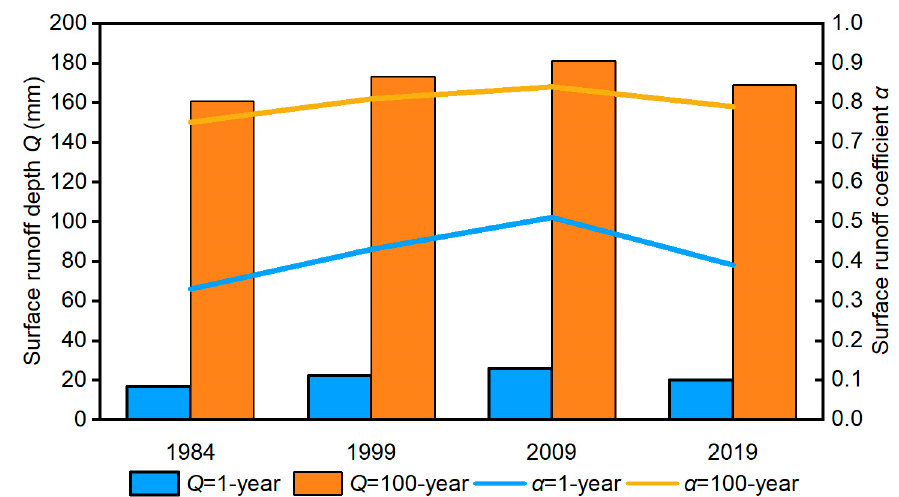
Figure 5. Average runoff depth Q (mm) and runoff coefficient α with the rainfall return period of 1a and 100a, under the land use conditions of 1984, 1999, 2009 and 2019.